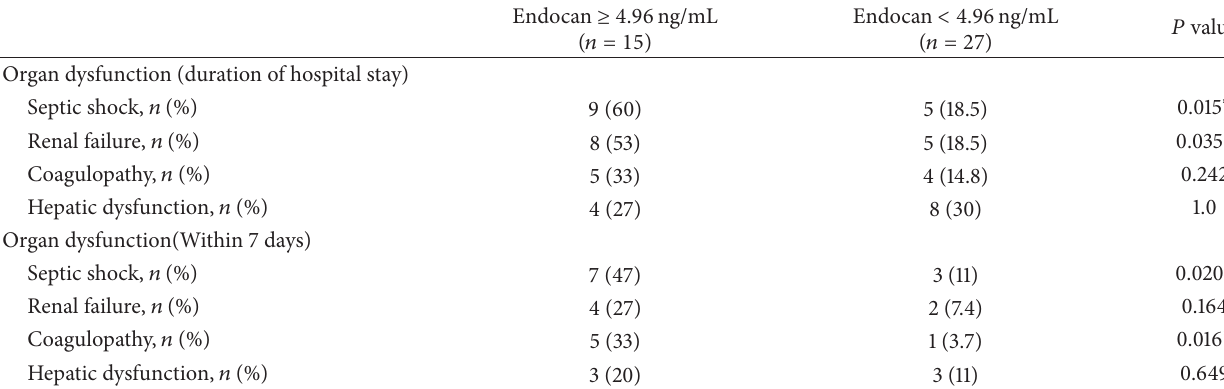
Table 5: Organ dysfunctions in patients with acute respiratory distress syndrome with low or high plasma endocan levels.